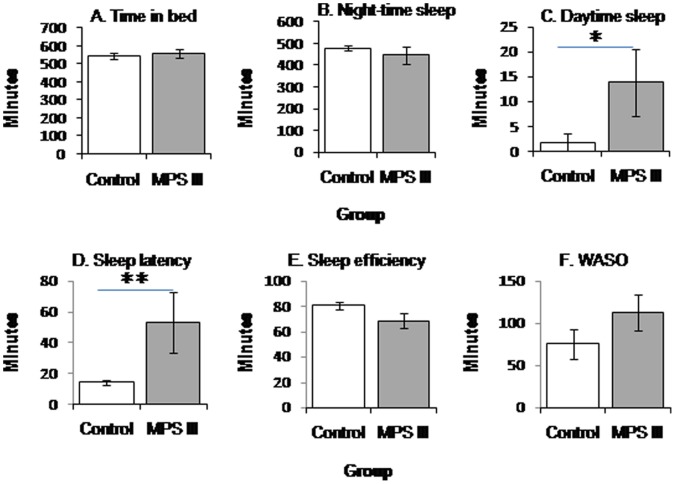
Mean actigraphic results of MPS III (n = 8) and control groups (n = 8).Error bars represent standard error of the mean. (A) Duration of time in bed. (B) Duration of night-time sleep. (C) Duration of daytime sleep. (D) Sleep onset latency. (E) Sleep efficiency. (F) Wake after sleep onset. * p<0.05, ** p<0.01.